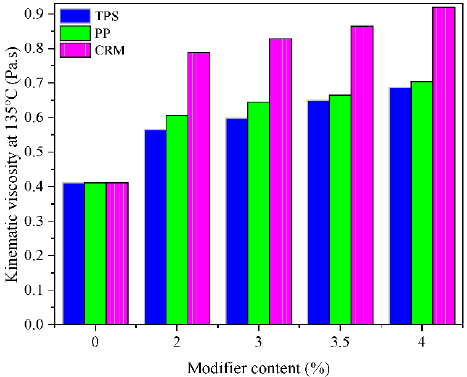
Figure 3. Effect of modifier content on viscosity.